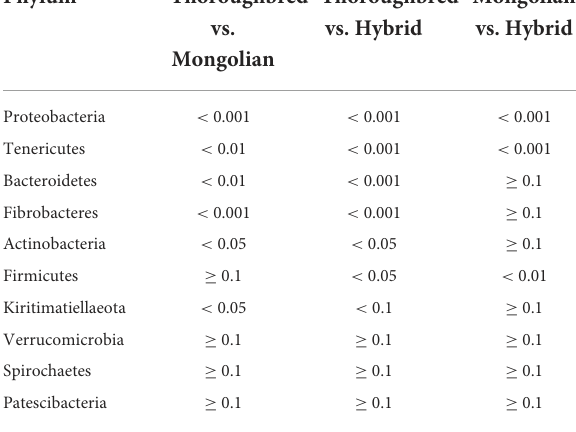
TABLE 1 Statistical analysis ( P -value) of the top 10 phyla abundance between paired